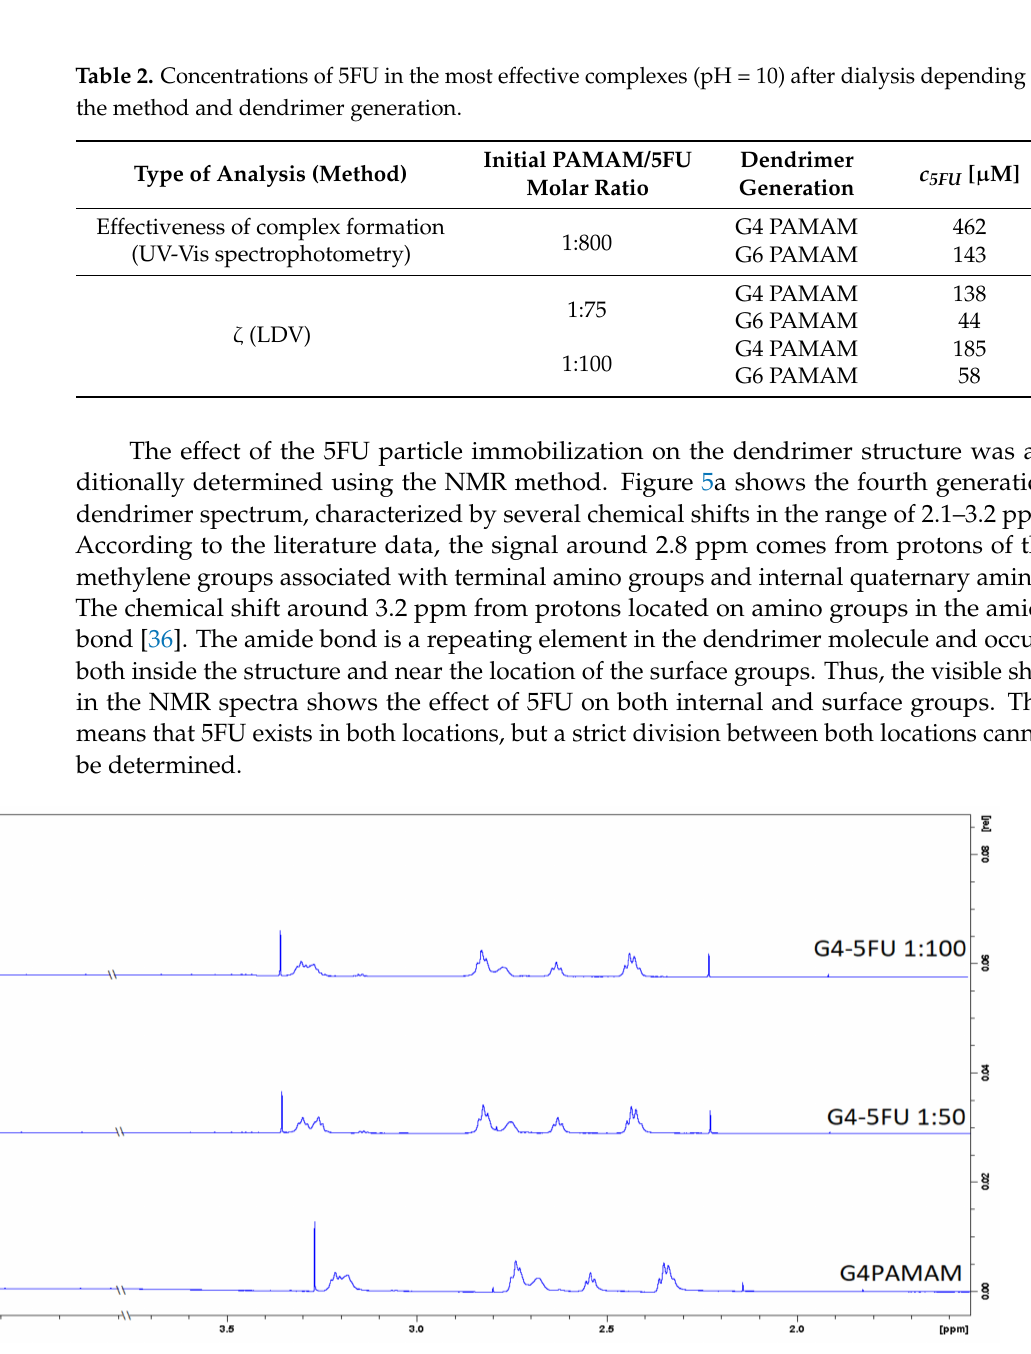
Figure 5. H 1 NMR spectra for G4PAMAM and G4-5FU complexes in 1:50 and 1:100 molar